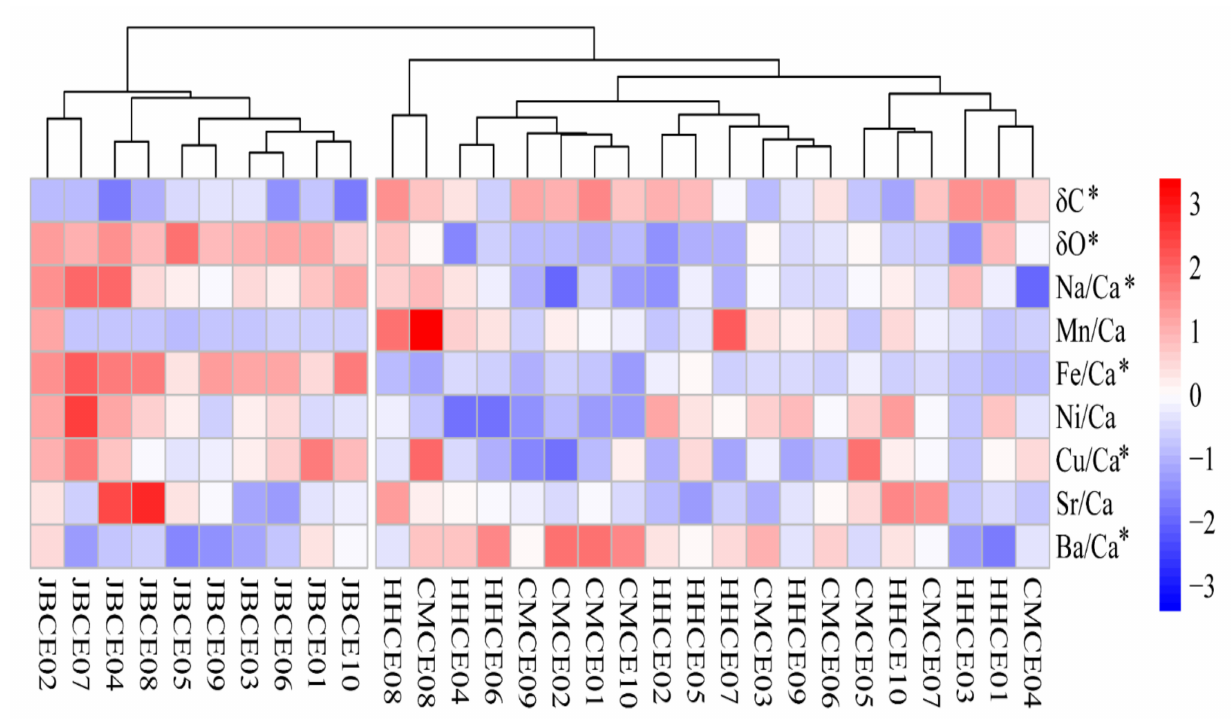
Figure 3. Microchemical characteristics of Coilia nasus from the Nantong coastal area of the Yellow Sea (HHCE), the Changjiang estuary near the Jiuduansha Shoal (CMCE), and the Jiubao bridge waters in the Qiantang estuary (JBCE), based on the Pheatmap. The different shades of blue and red reflect different values. The (*) symbol represents a significant difference ( p < 0.05, one-way ANOVA).